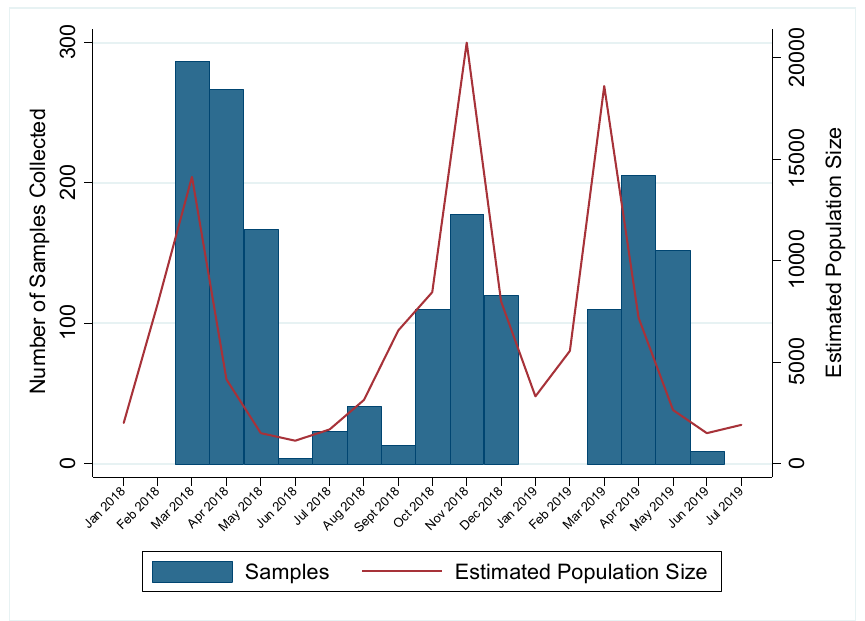
Figure 1. Number of samples collected for influenza A virus (IAV) surveillance in mallards and estimated population size of all waterfowl species near Port Clinton, Ohio, USA by month. Year-round IAV surveillance was conducted in wild mallards ( Anas platyrhynchos ) in one location for two years (July 20217–July 2019) to better capture the under-sampled spring migration. Samples for IAV surveillance collected from mallards by active trapping (January–August) and hunter harvest (September–December) are shown by blue bars. Estimated population size of waterfowl at the study location is shown by the red line. Data is shown as starting January 2018 as estimated population size was not available before that time.